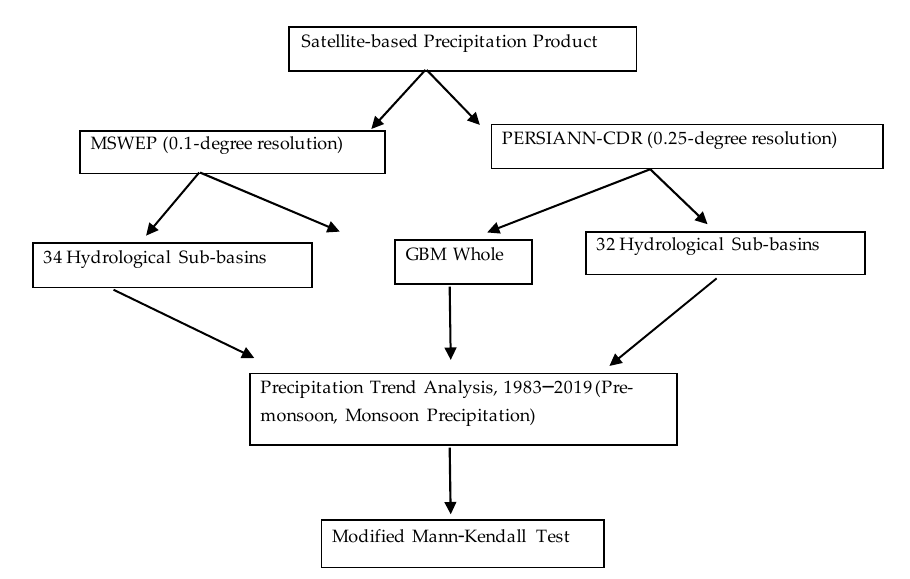
Figure 2. Hydrological sub-basins’ boundaries of the Pfafstetter level-05 of GBM. Numbers are the Pfafstetter identification codes. Country boundaries are the red lines.